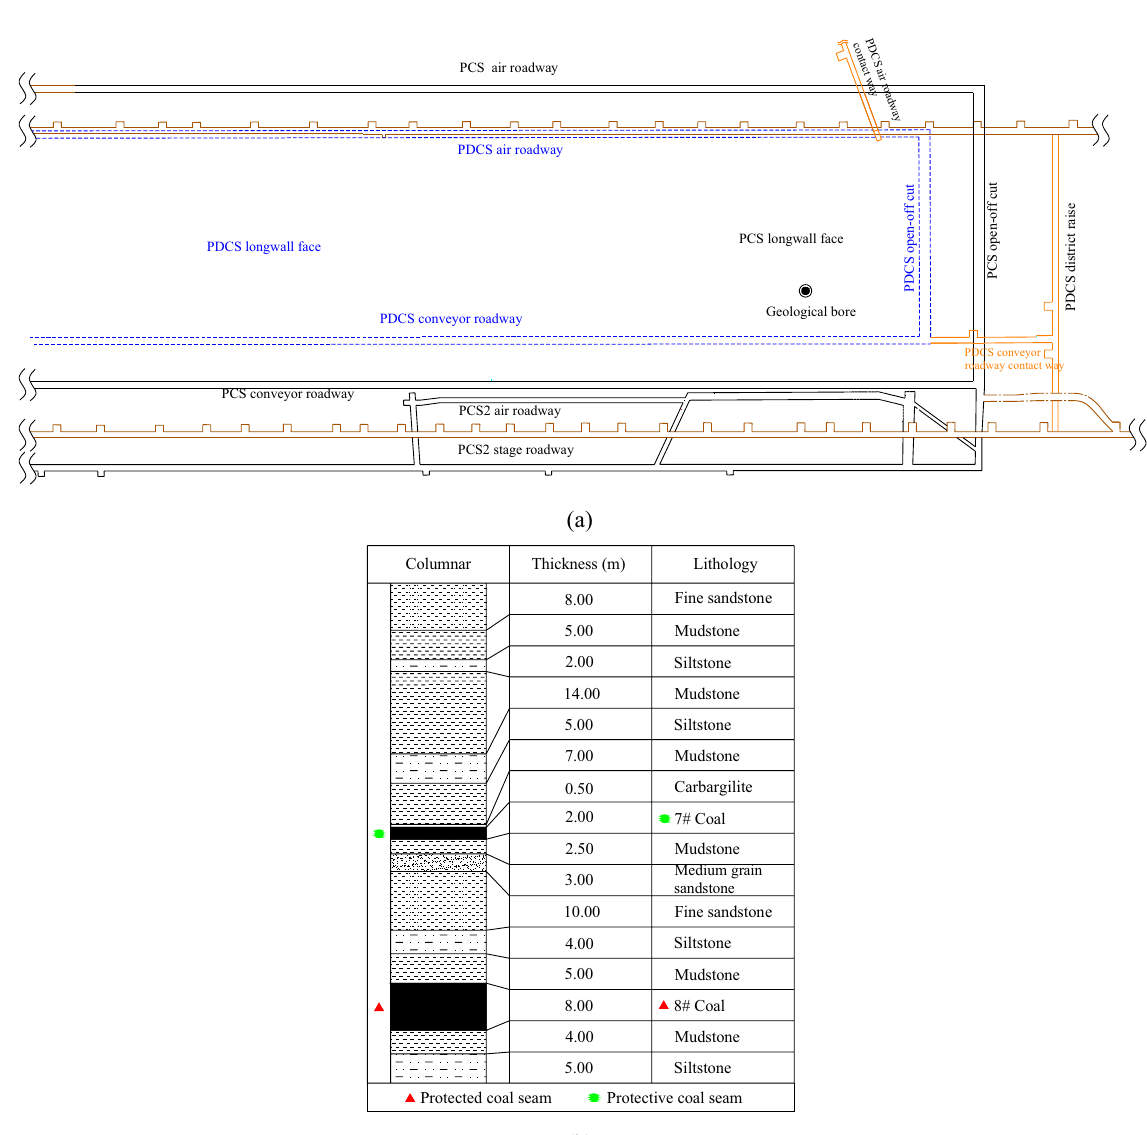
Figure 2. Location of PCS and PDCS longwall face at the coal mine ( a ) and borehole diagram of coal measures ( b